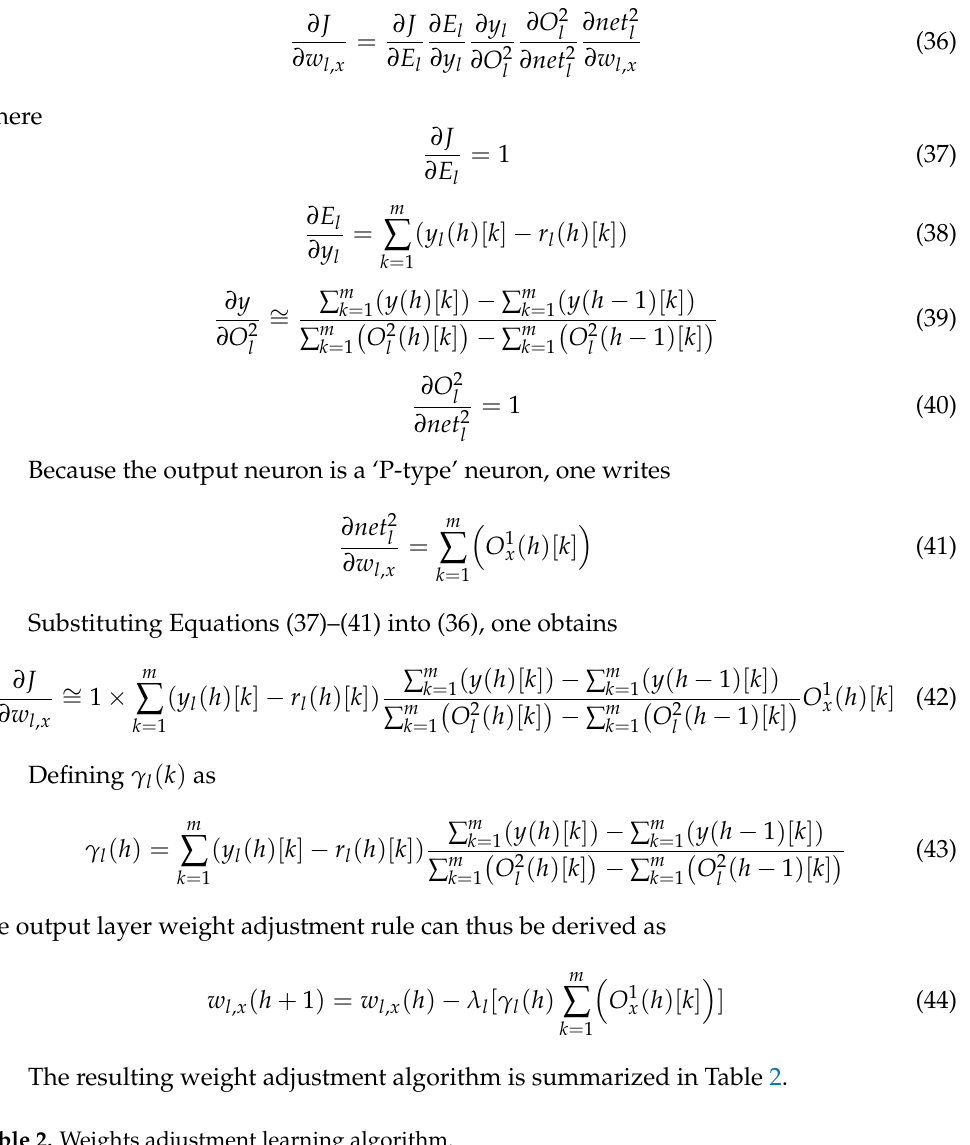
Table 2. Weights adjustment learning